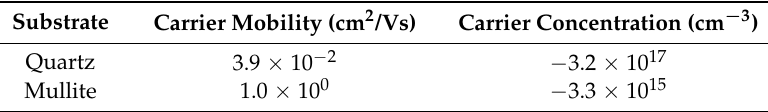
Table 2. The mobility and the carrier concentration values of Si/SiC ML thin film samples on the mullite and the quartz substrates at room